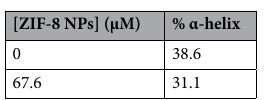
Table 2. Percentage α-helix content of BSA in presence and absence of ZIF-8